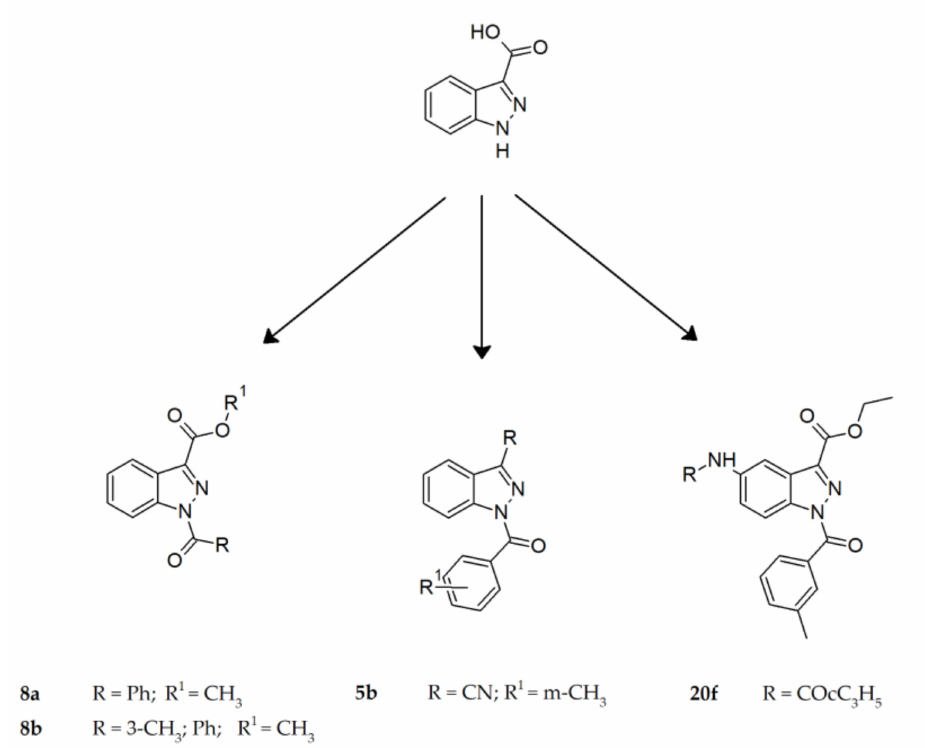
Figure 14. N -benzoylindazole derivatives presented in the papers by Crocetti et al.